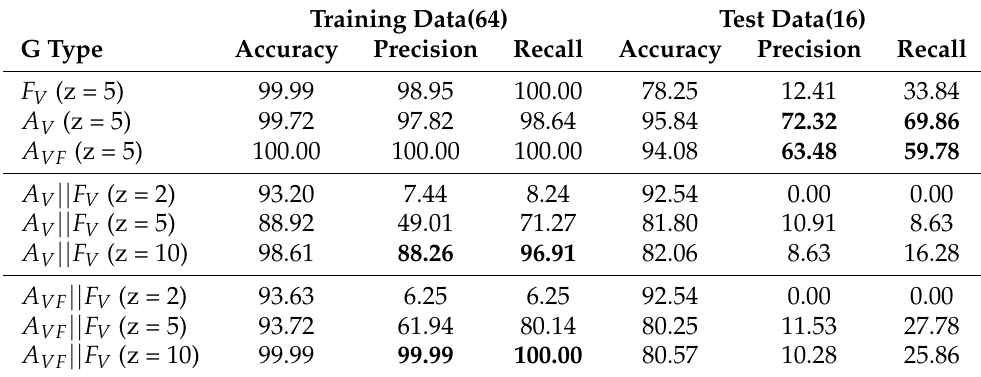
Table 1. Performance on 3D geometry generation.